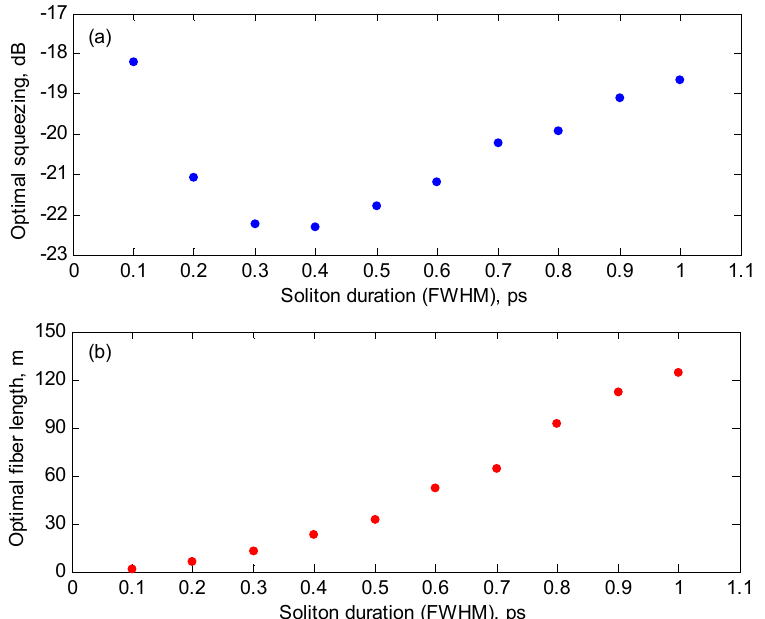
Figure 4. Optimal squeezing ( a ) and corresponding optimal fiber length ( b ) as functions of soliton duration.